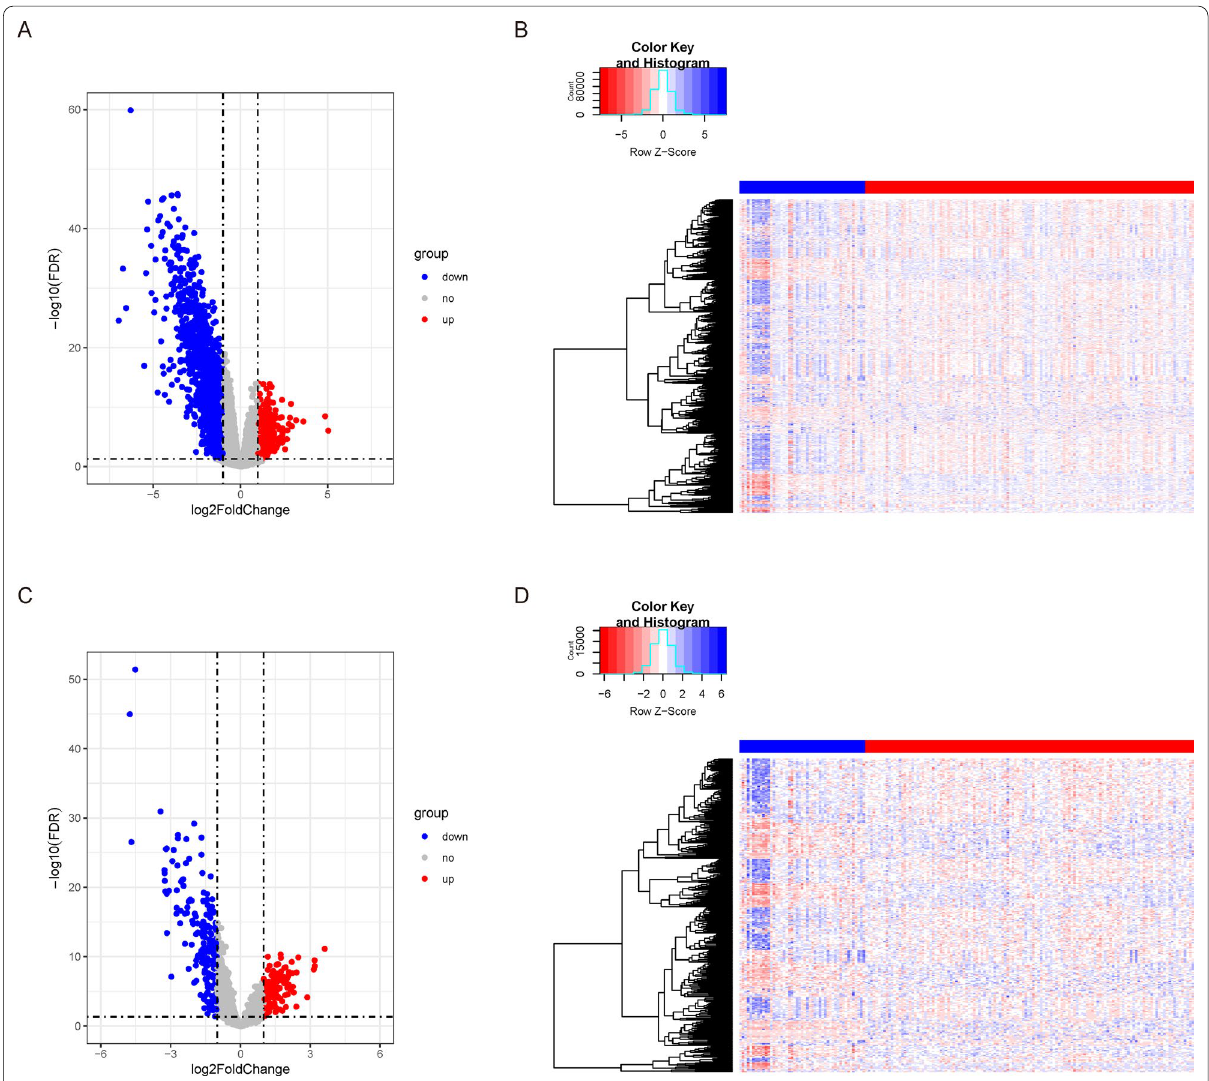
Fig. 2 Statistics on differential expression. Volcano plot for differential gene expression, with the upregulated genes represented by red and the downregulated genes represented by blue ( A : mRNAs; C : lncRNAs). Heat map for differential gene expression, with the red legend depicting the mutated samples, the blue legends depicting the non-mutated samples, and the decrease of expression demonstrated from blue to red ( B : mRNAs; D :